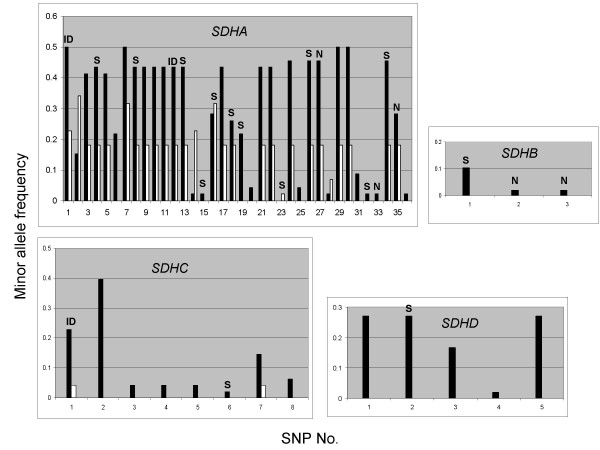
Minor allele frequency of each SDH subunit variant (also see Additional Table 1) is shown. Filled vertical bars refer to African American, unfilled vertical bars refer to European American samples. Synonymous and non-synonymous coding variants are marked by S and NS, respectively. ID refers to insertion/deletion polymorphisms.